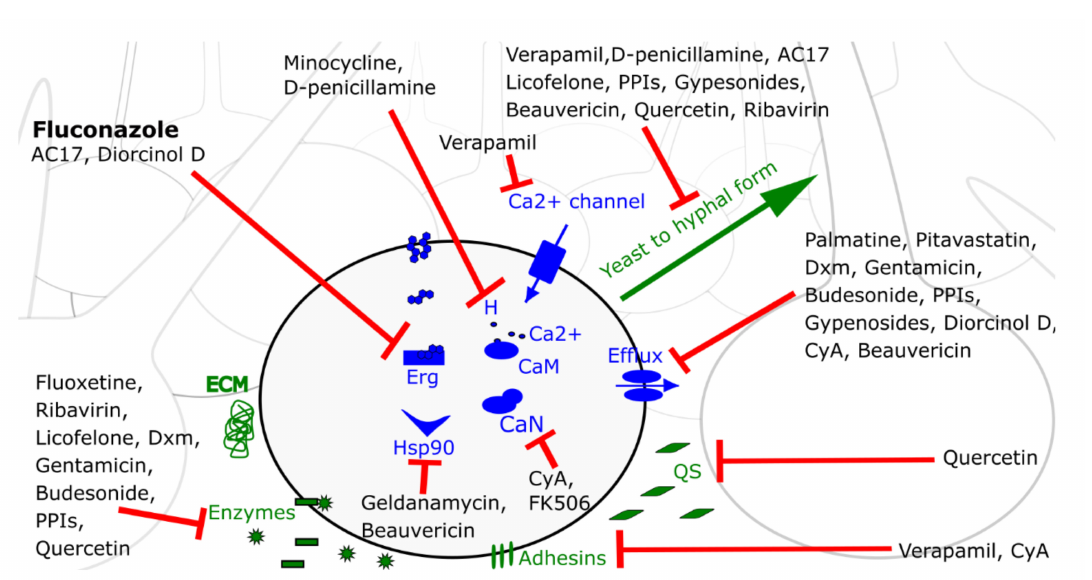
Figure 1. Schematic representation of a C. albicans cell in a biofilm context. Important virulence factors and cellular components / pathways involved in C. albicans biofilm tolerance are indicated in green and blue, respectively. Fluconazole potentiators are listed with their main modes of action (red arrows), as discussed in this review. Abbreviations : Erg, ergosterol biosynthesis pathway; CaM, calmodulin; CaN, calcineurin; QS, quorum sensing; ECM, extracellular polymer matrix; H, calcium homeostasis in general; PPIs, proton pump inhibitors; Dxm, dexamethasone; CyA, cyclosporine